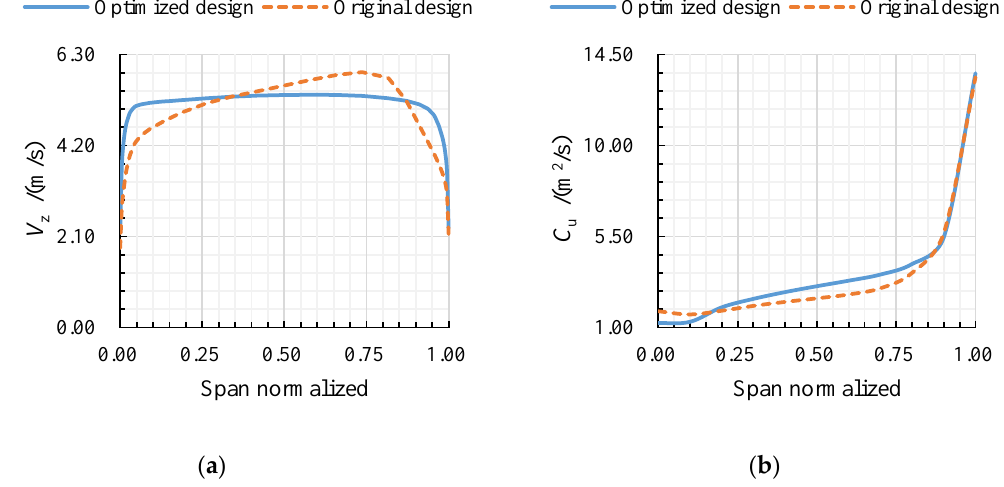
Figure 16. Comparison of the velocity distribution in the impeller between the original design and optimized design under the reverse design flow rate (span = 0.5).